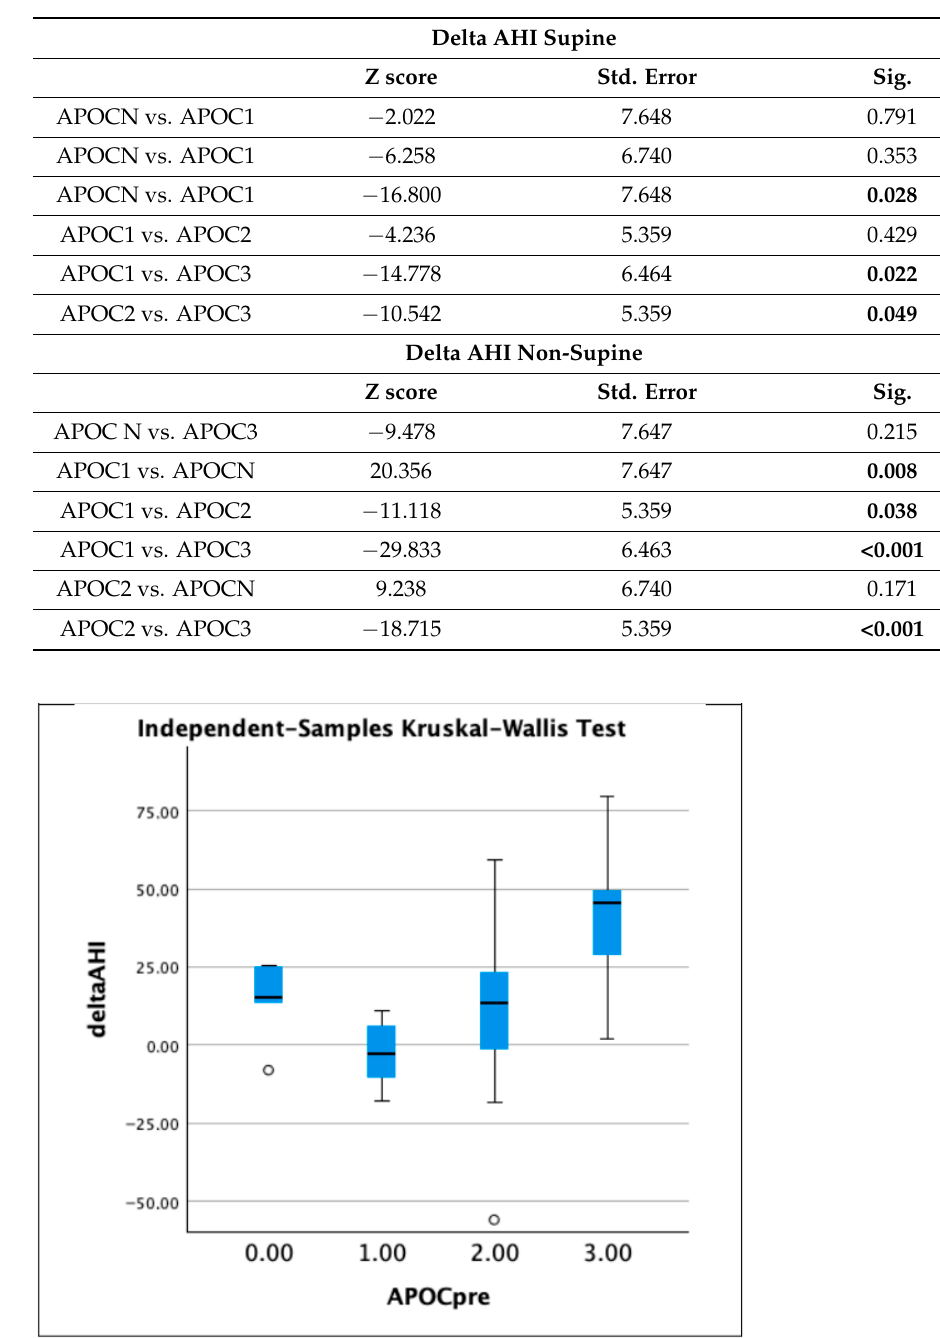
Figure 3. Boxplots showing delta AHI in patients divided in groups according to APOC classification (group 0 stands for non-classifiable APOC; 1.00 = APOC 1, 2.00 = APOG 2, and 3.00 = APOC 3). Circle represent outliers.